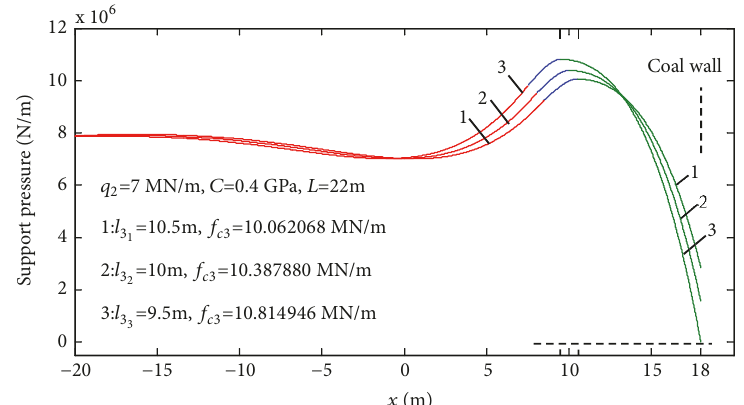
Figure 16: Support pressure curves of coal seam for different softening area depths.